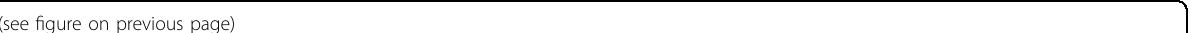
Fig. 5 Ptf1a -Cre independent accumulation of Tn-modi fi ed proteins in pancreatic islets with consecutive beta cell failure. a Assessment of Tn antigen (green) and insulin expression (red) in pancreatic sections from 4 and 40-week-old WT and Cosmc- KO fasting mice. Tn antigen expression is only observed in Cosmc- KO tissue, and Tn antigen positivity is restricted to exocrine glands in young animals, whereas prolonged Tn antigen staining is observed in islets of Langerhans in aged mice. Scale bar equals 200 µm. b Cel IHC staining of adult WT and KO tissue and IF co-staining of VVA (green) and Cel (red). Scale bar equals 200 µm. c Quanti fi cation of islets of Langerhans of WT ( n = 68) and KO ( n = 64) pancreata ( P = 0.004). d VVA Western blot analysis of endo- and exocrine pancreatic tissue derived from WT and Cosmc- KO animals. VVA positivity is speci fi c for KO tissue, with most of the Tn-modi fi ed proteins found in exocrine tissue. Anti-trypsin was used as an exocrine marker. e Western blot analysis of WT and Cosmc- KO endocrine tissue using anti-Cel antibody. The analysis shows that the localization of Cel is not limited to the exocrine pancreas. f VVA precipitation from endocrine WT and KO tissue lysates with WB detection using anti-Cel antibody. g Comparison of NT-3 cell viability in the presence of 20 µM CEL and CEL-Tn after 48 h shows no signi fi cant difference. h CEL-Tn shows a signi fi cant negative regulation of glucose-stimulated insulin secretion in NT-3 cells. Cells were stimulated with 25 mM glucose for 60 min in the presence of 20 µM recombinant CEL or